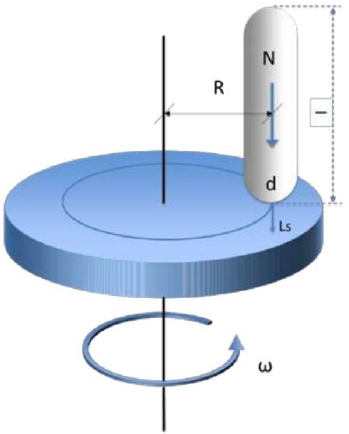
Figure 5. Diagram of the Pin-on-Disc test method